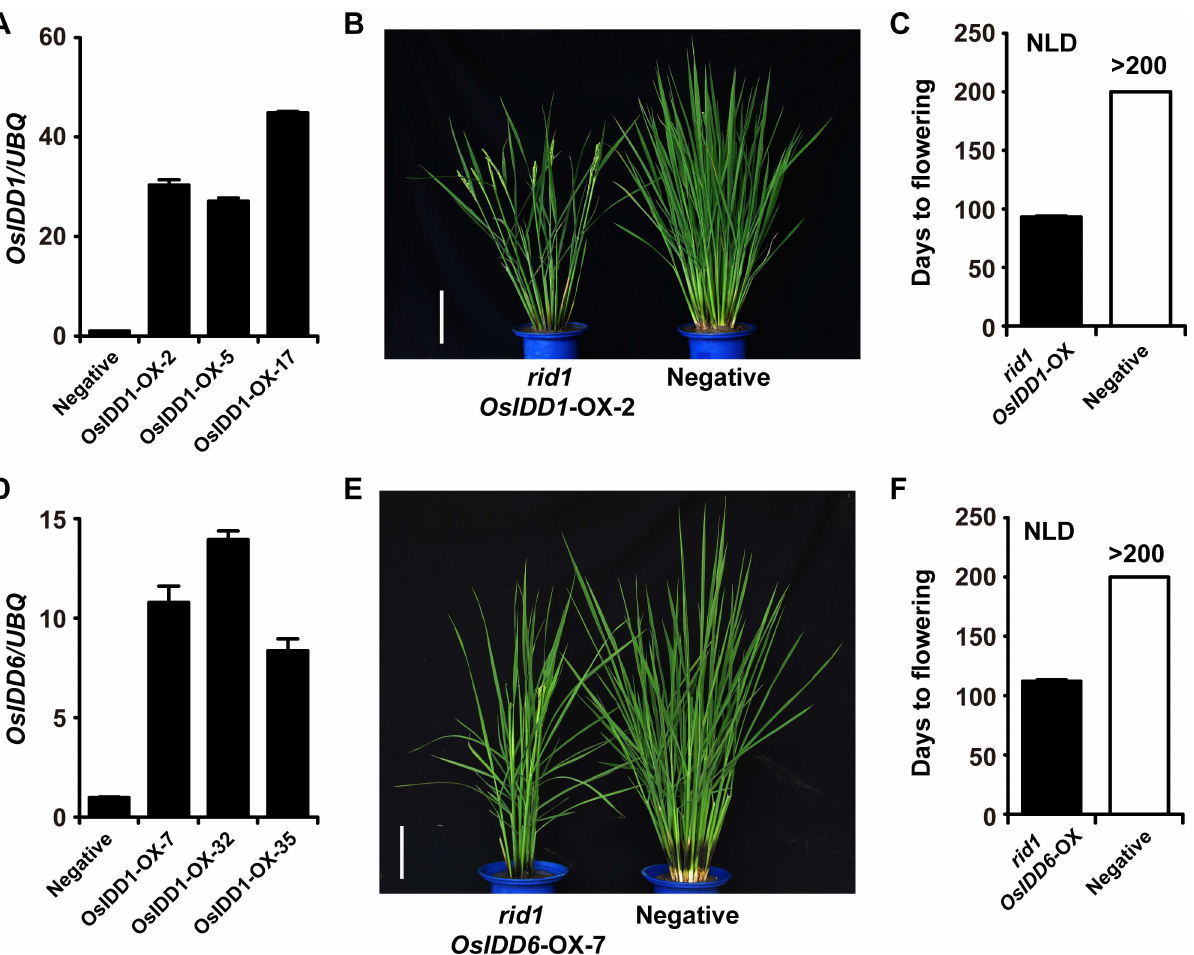
Fig 3. Characterization of transgenic plants overexpressing OsIDD1 and OsIDD6 in rid1 . (A) Expression level of independentT0 transgenicfloweringlines generatedby transforming homozygous callus of rid1 with pUBQ :: OsIDD1 . Negative, transgene-negative control plant. (B) Phenotypesof transgene-negative control plant and rid1 pUBQ :: OsIDD1 at headingstage. Scale bar, 15 cm. (C) Days to flowering under natural-long-day (NLD) conditions. Black boxes, rid1 pUBQ :: OsIDD1 transgenicplants; empty boxes, transgene-negativecontrol plant ( n = 10). (D) Expression level of independentT0 transgenicfloweringlines generated by transforming homozygouscallus of rid1 with pUBQ :: OsIDD6 . Negative,transgene-negative control plant. (E) Phenotypesof transgene-negativecontrol plant and rid1 pUBQ :: OsIDD6 at headingstage. Scale bar, 15 cm. (F) Days to floweringunder NLD conditions. Black boxes, rid1 pUBQ :: OsIDD6 transgenicplants; empty boxes, transgene-negative control plant ( n =